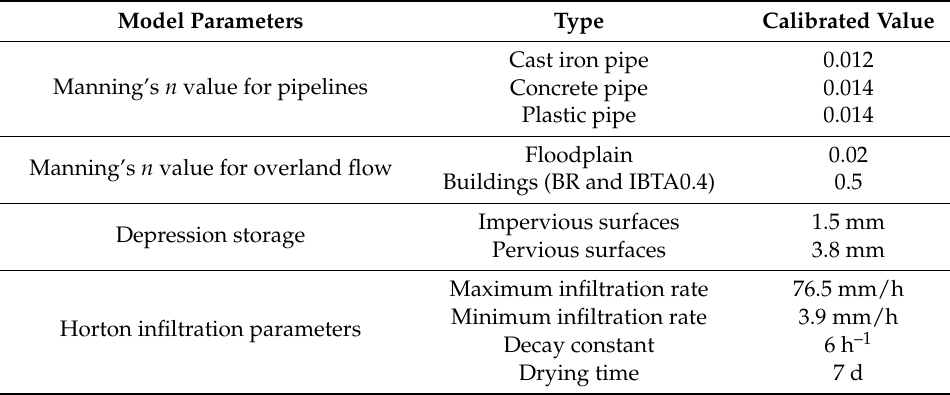
Figure 11. Model response of RMSE D for varying Manning’s n value of buildings. The dotted line represents the optimal Manning’s n value of buildings used in the BR and IBTA0.4R methods. Table 2. The calibrated model parameters for the model.